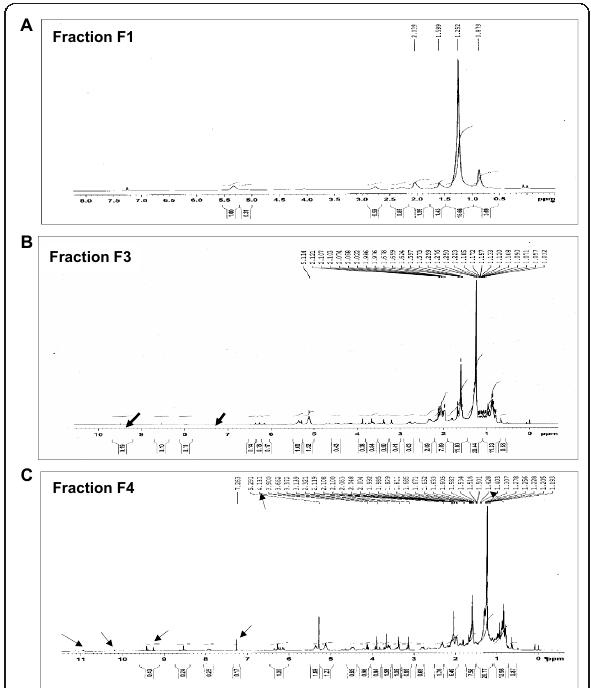
Figure 4 Anti-HPV and anti-cancer effect of B. pinnata crude leaf extract and fraction F4 in cervical cancer cells . A . Northern blot analysis of HPV18 positive HeLa cells incubated with indicated concentrations of crude leaf extract and fraction F4. Quantity and quality of total RNA (15 μ g/lane) extracted was examined on agarose gel by assessing 28S & 18S ribosomal RNAs (upper panels). The membranes were hybridized with HPV18-specific probe (middle panel), stripped and rehybridized with b -actin -specific DNA probe as an internal control to assess equal loading (lower panels). B . Aggregated mean (± S.D.) abundance ratio of HPV18 transcript w.r.t. to b -actin following treatment with indicated doses of crude extract (a) and fraction F4 (b) in three independent experiments. The abundance ratio HPV18 transcript to b -actin mRNA was analyzed by densitometry as described in “ Methods ” and their ratio in untreated control was used as reference. C . Immunoblotting analysis of Bcl-2, and Bax, caspase-3, poly (ADP-ribose) polymerase-1 (PARP- 1), in fraction F4 treated HeLa cells at different time-intervals. D . The abundance ratio of indicated proteins to b -actin was analyzed by densitometry and their ratio in untreated control was used as reference. The values indicate aggregated mean ± S.D. of three independent experiments. *p < 0.05 versus untreated control cultures.